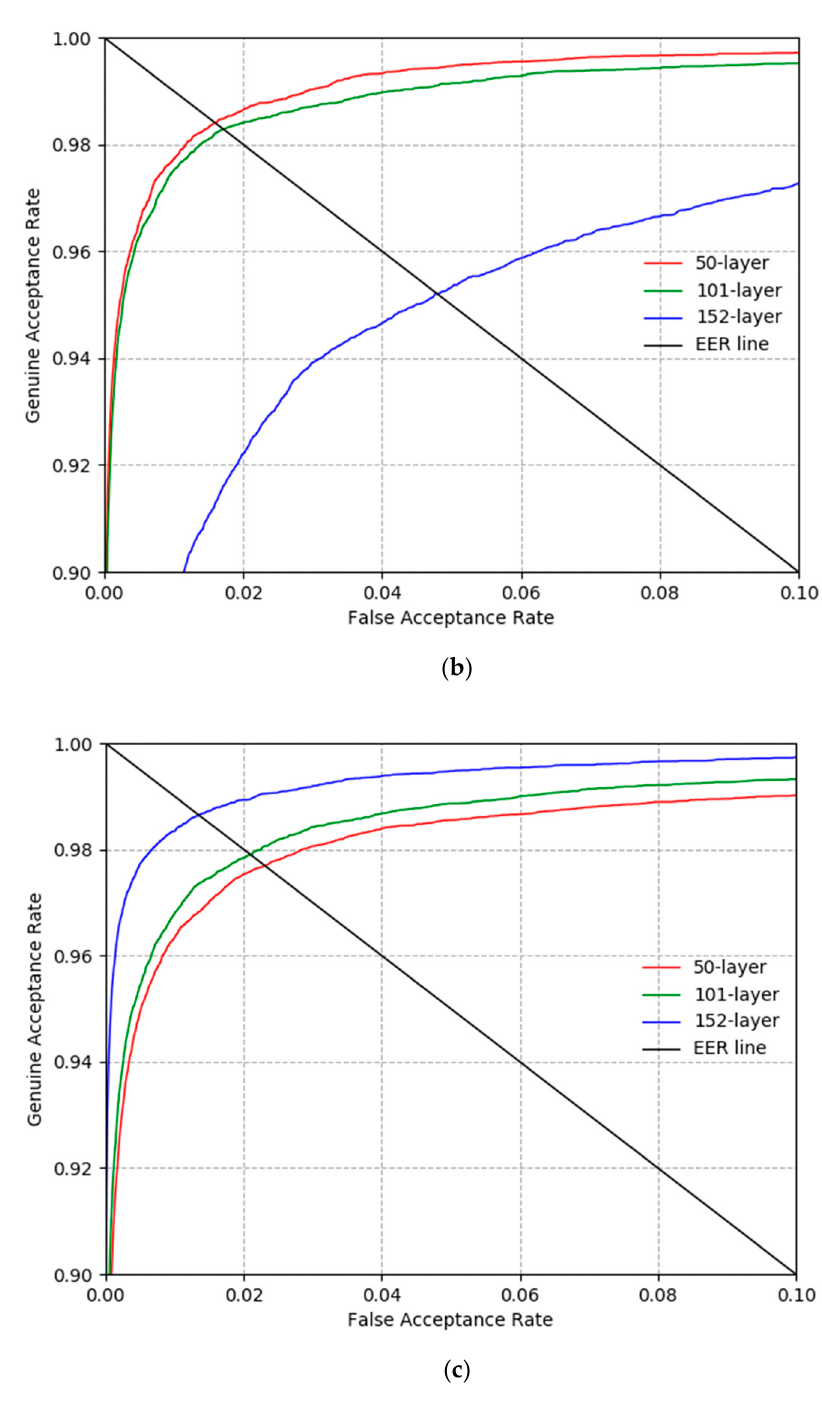
Figure 8. ROC curves of recognition by ResNet-50, 101, and 152 with ( a ) CASIA-Iris-Distance, ( b ) CASIA-Iris-Lamp, and ( c ) CASIA-Iris-Thousand.